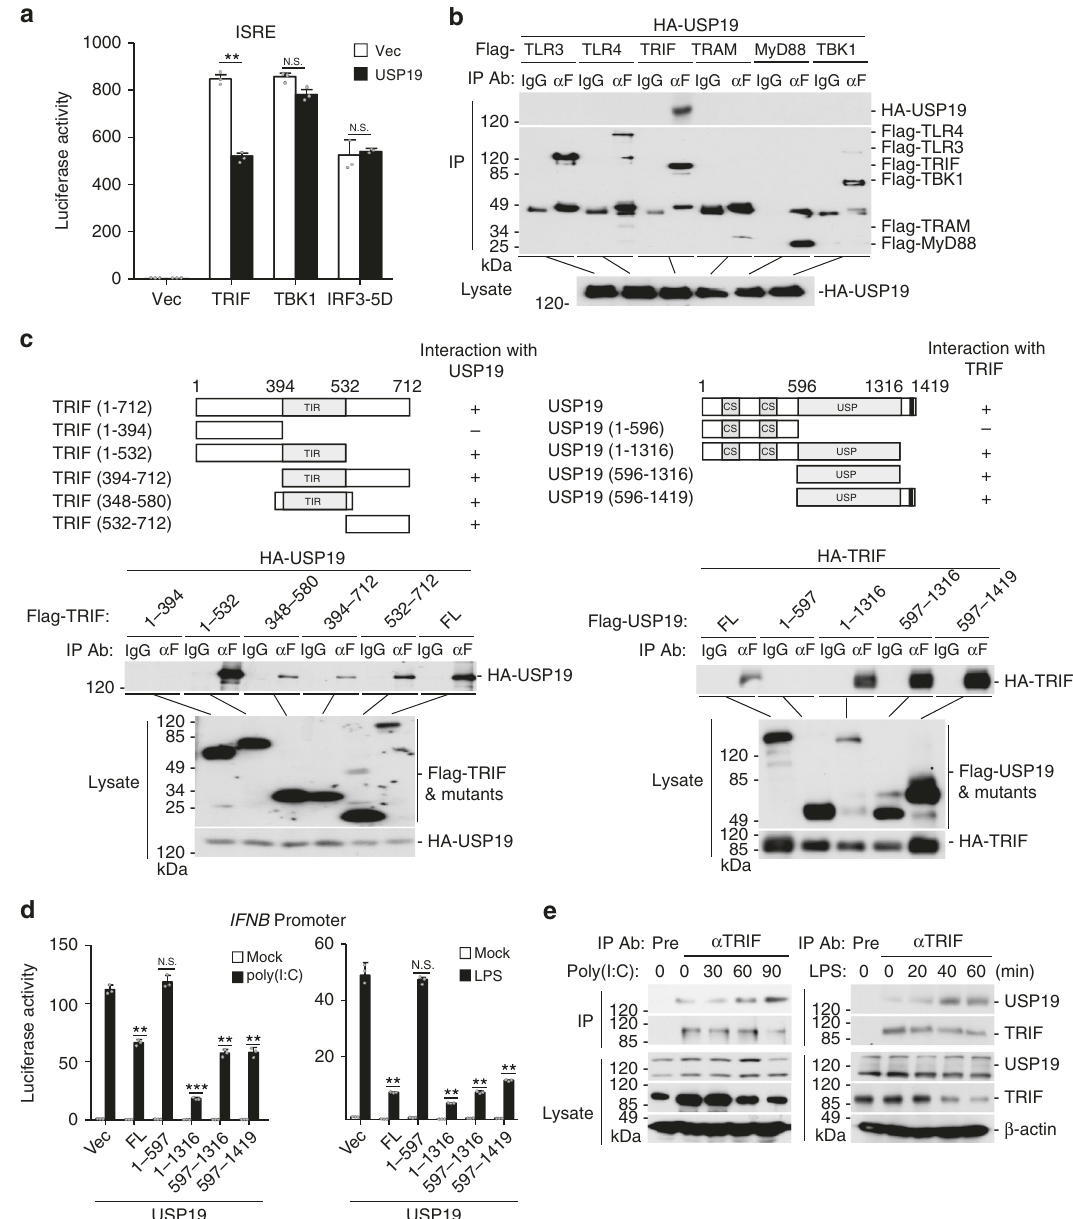
Fig. 4 USP19 acts at the level of TRIF. a Overexpression of USP19 inhibits TRIF-mediated ISRE activation. HEK293 cells were transfected with ISRE reporter and the indicated adapter expression plasmids together with a control or USP19 expression plasmid for 24 h before luciferase assays were performed. Graphs show mean ± SD; n = 3 independent samples. ** P < 0.01 (unpaired t -test); N.S., not signi fi cant. b USP19 interacts with TRIF in overexpression systems. HEK293 cells were transfected with HA-USP19 and the indicated adapter expression plasmids. Twenty hours after transfection, co- immunoprecipitation was performed with anti-Flag or control IgG. The immunoprecipitates and lysates were analyzed by immunoblotting with anti-HA or anti-Flag. c Domain mapping of the interaction between USP19 and TRIF. HEK293 cells were transfected with the indicated truncations before co- immunoprecipitation and immunoblotting analysis with the indicated antibodies. The schematic presentations of USP19 and TRIF truncations are shown at the top. d Effects of USP19 and its truncations on poly(I:C)- and LPS-induced IFN- β promoter activation. The 293-TLR3 or 293-TLR4 cells were transfected with the IFN- β promoter reporter and Flag-USP19 or its truncations for 24 h, and then left untreated, treated with poly(I:C) (50 μ g/mL) or LPS (100 ng/ml) respectively for 8 h before luciferase assays. Graphs show mean ± SD; n = 3 independent samples. ** P < 0.01, *** P < 0.001 (one-way ANOVA followed by Dunnett ’ s test); N.S., not signi fi cant. e Endogenous USP19 is associated with TRIF. The 293-TLR3 or 293-TLR4 cells were left untreated or treated with poly (I:C) (100 μ g/ml) or LPS (100 ng/ml) respectively for the indicated times. Cell lysates were immunoprecipitated with anti-TRIF or control IgG. The immunoprecipitates and lysates were analyzed by immunoblotting with indicated antibodies. Data are representative of three experiments with similar results. Source data are provided as a Source Data fi le. Error bars represent standard deviation of the